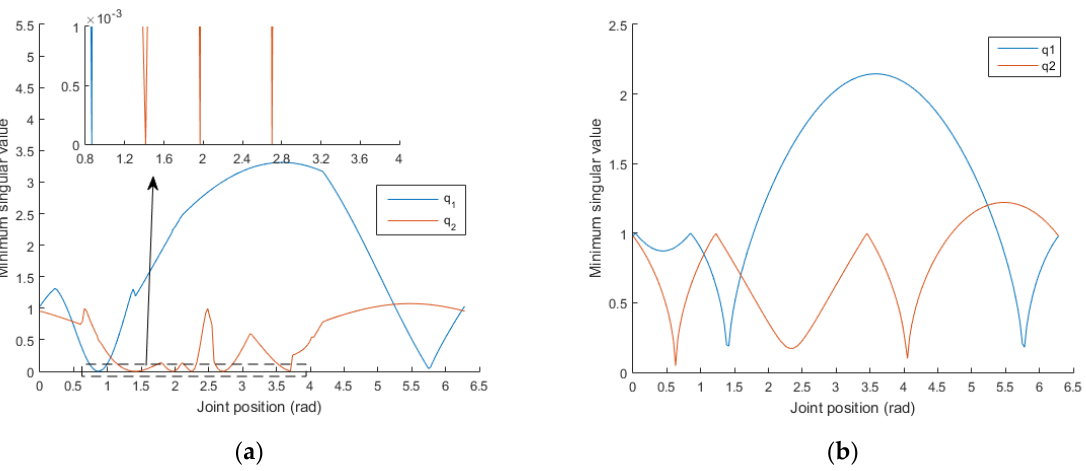
q and 1 q and q . 1 2